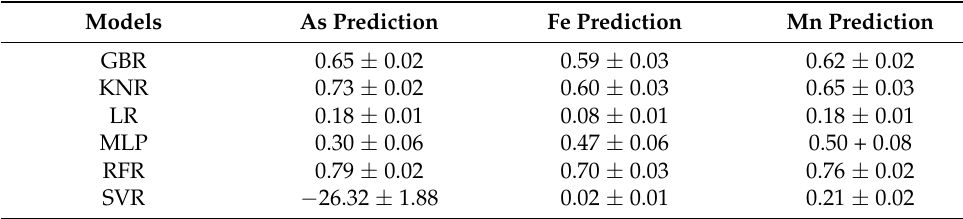
Table 2. Model performance on 100 testing data sets for different targets (mean R 2 score ± standard